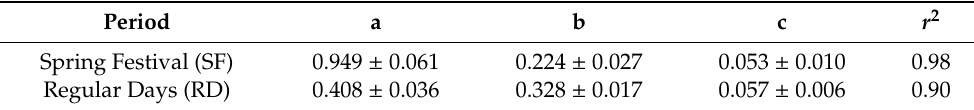
Figure 8. Modeled rBC mass by tri-linear regression compared with the measurements: ( a ) time series of the ratio of the residual to the measured rBC, ( b ) time series of the residual of the fit to the measured rBC, ( c ) the variations of the fitting residuals and the average contribution of different components to rBC.